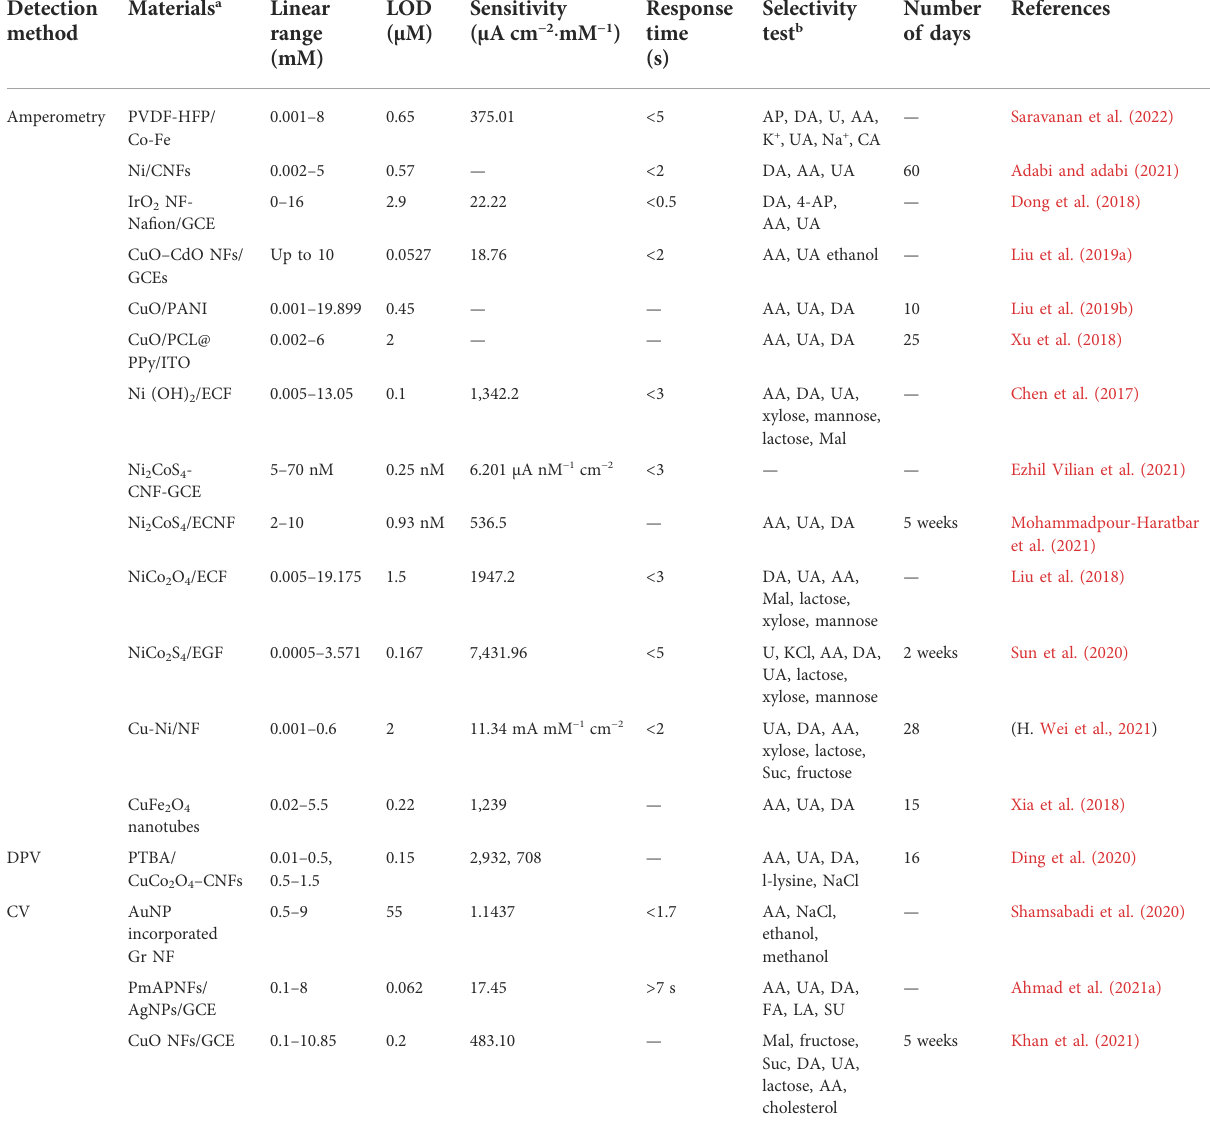
TABLE 5 Non-enzymatic electrospun NF-based sensors for glucose detections, with analytical characteristics. Detection